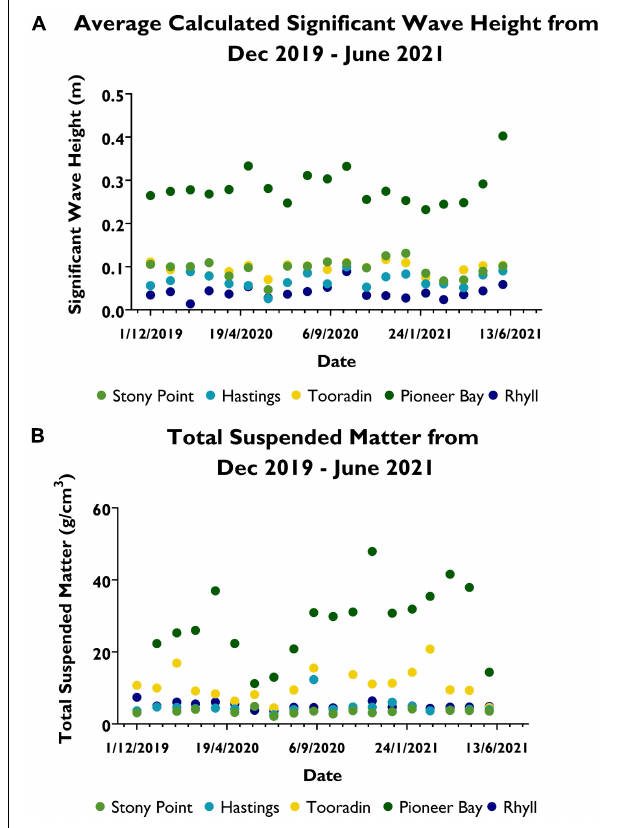
FIGURE 3 | (A) Average monthly calculated significant wave height during December 2019 to June 2021. (B) Total suspended matter (TSM)